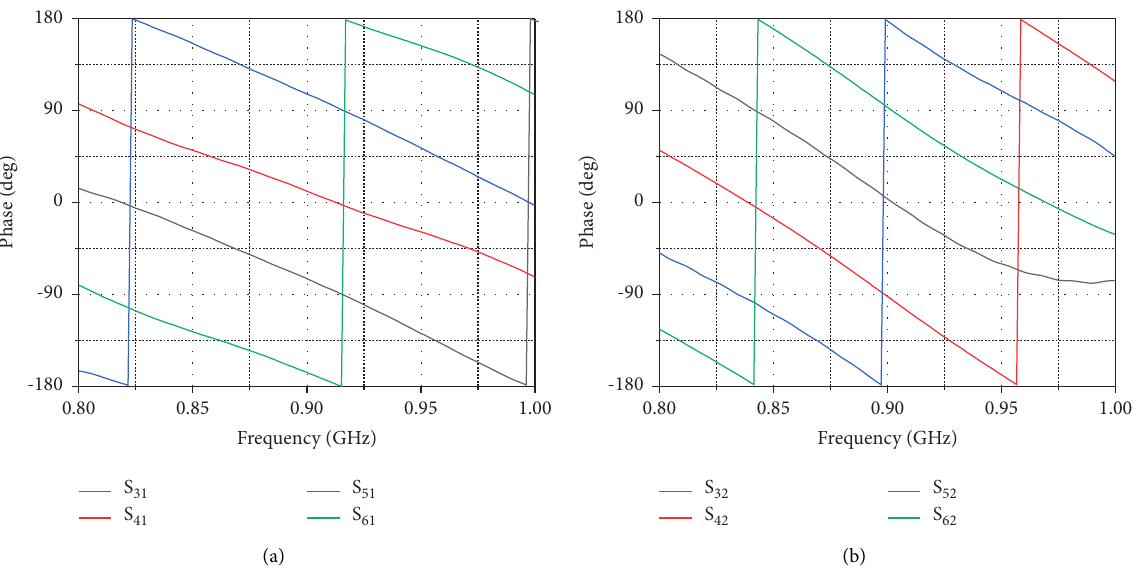
Figure 3: Phase progression in (a) Port 1 to make up LHCP signal and (b) Port 2 to make up RHCP